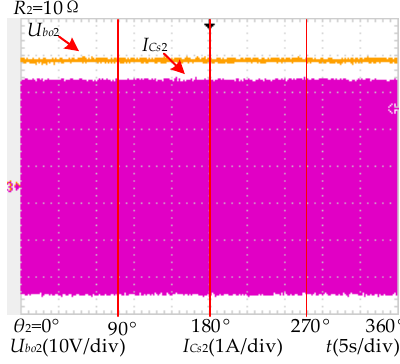
Figure 16. The variation of output voltage and input current with the rotation of the secondary coil. The output power and the efficiency are listed in Table 4. Table 4. The output power and the efficiency.